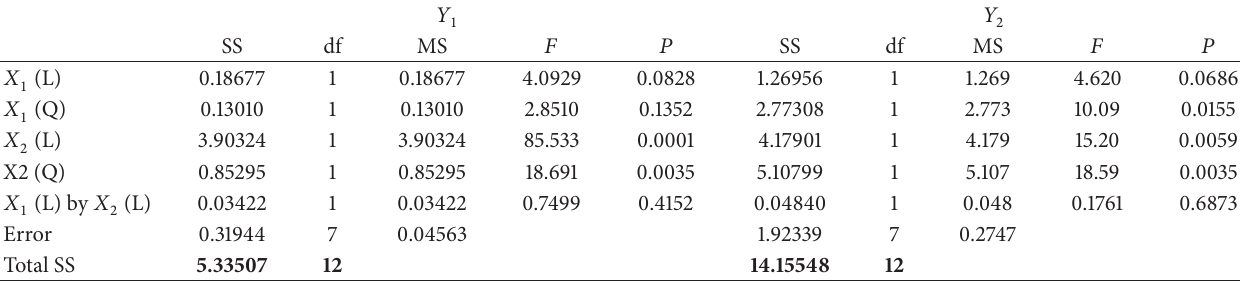
Table 4: ANOVA of flexural strength and split tensile strength.